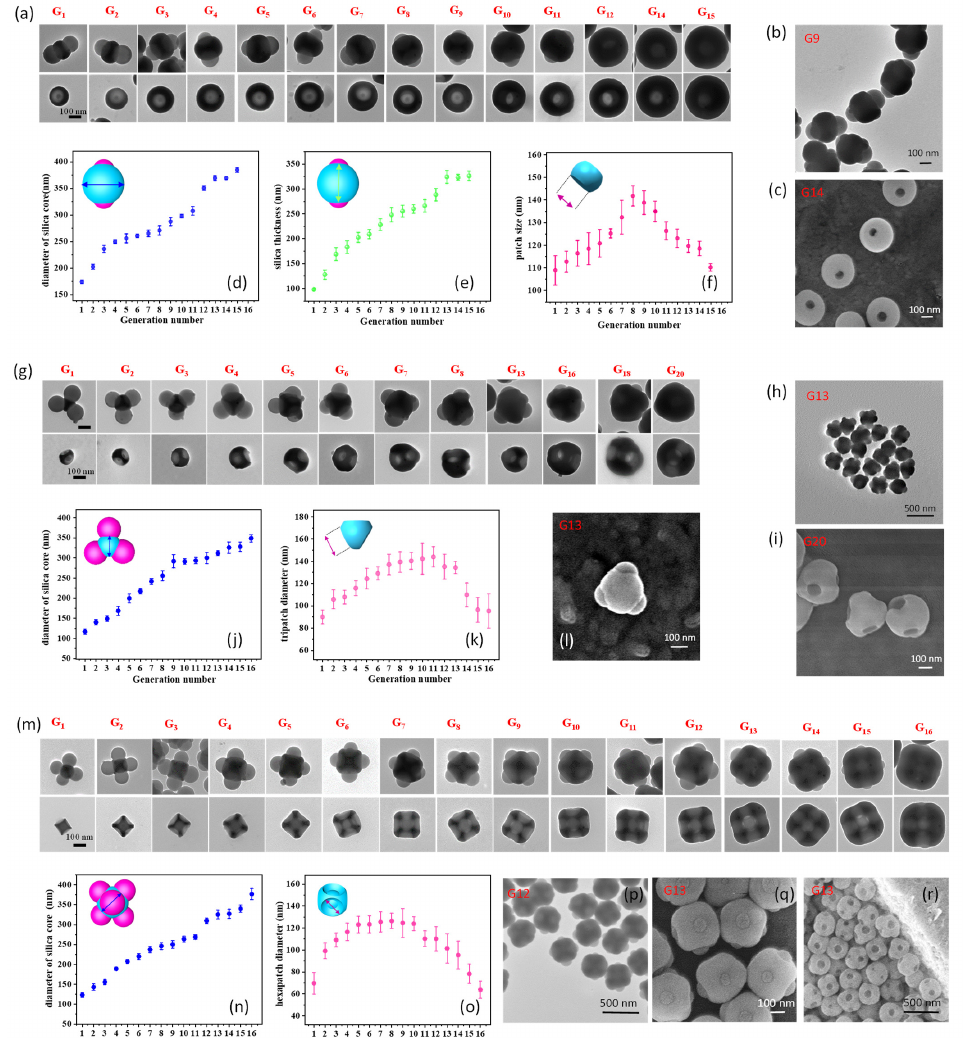
Figure 1. ( a ) TEM images of the bipod-like particles obtained after 1 to 15 iterative silica growth steps (corresponding to generations #1 to #15). The bottom row shows images of the corresponding two-patch particles obtained after dissolution of the PS nodules. All images are at the same scale; ( b ) Low magnification TEM image of the bipod-like particles after 9 iterative silica growth steps; ( c ) Scanning electron microscopy (SEM) image of the two-patch particles of generation #14; ( d , e ) Evolution of the diameter and the thickness of the silica core as a function of the generation number; ( f ) Evolution of the patch size as a function of the generation number; ( g ) TEM images of the tripod-like particles obtained after 1 to 20 iterative silica growth steps. The bottom row shows images of the corresponding three-patch particles obtained after dissolution of the PS nodules. All images are at the same scale; ( h ) Low magnification TEM image of the tripod-like particles after 13 iterative silica growth steps; ( i ) SEM image of the three-patch particles of generation #20; ( j ) Evolution of the diameter of the silica core as a function of the generation number; ( k ) Evolution of the patch size as a function of the generation number; ( l ) SEM image of a tripod-like particle of generation # 13; ( m ) TEM images of the hexapod-like particles obtained after 1 to 16 iterative silica growth steps. The bottom row shows images of the corresponding six-patch particles obtained after dissolution of the PS nodules. All images are at the same scale; ( n ) Evolution of the diameter of the silica core as a function of the generation number; ( o ) Evolution of the patch size as a function of the generation number; ( p ) Low magnification TEM image of the hexapod-like particles after 12 iterative silica growth steps; ( q ) SEM image of the hexapod-like particles of generation #13; ( r ) SEM image of the six-patch particles of generation